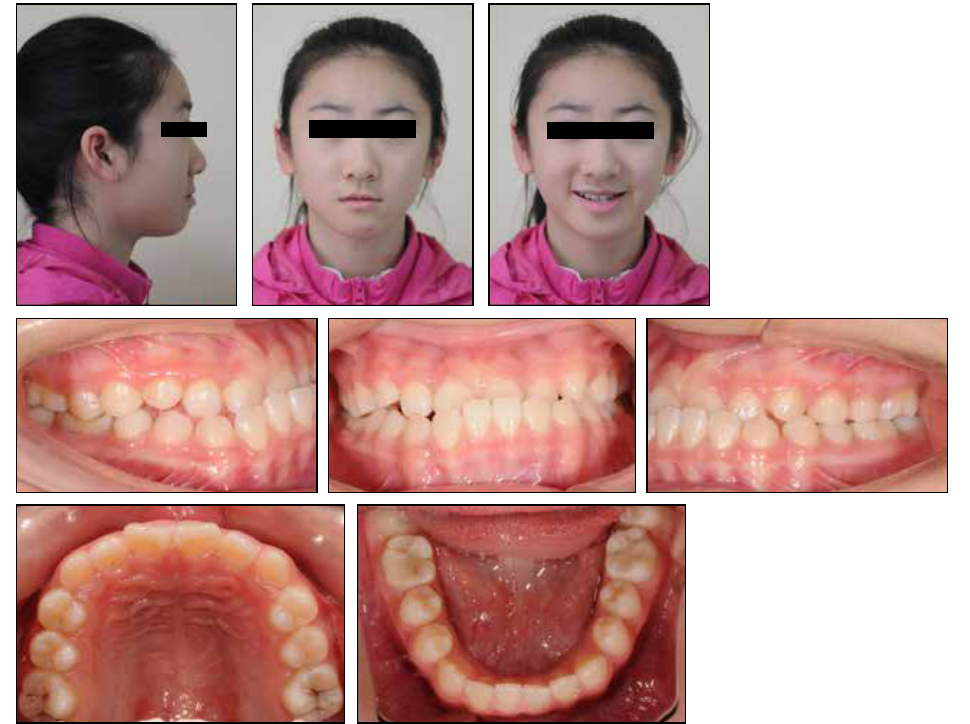
Figure 1. Pretreatment facial and intraoral